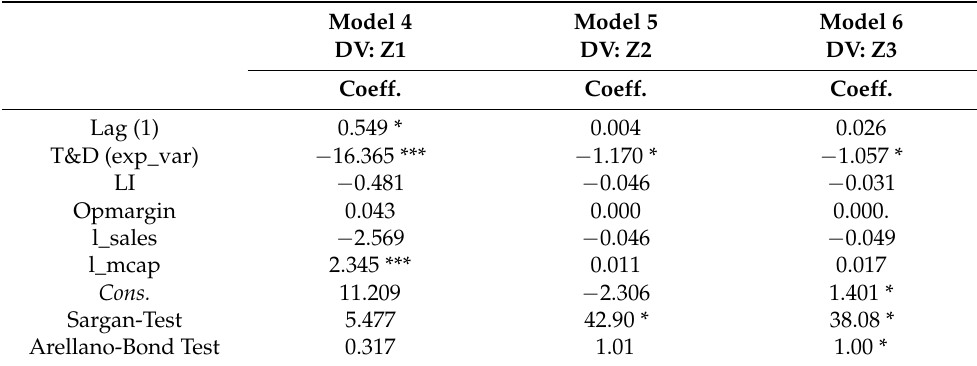
Table 5. Base Models for Linear Relationship (Dynamic Panel Data